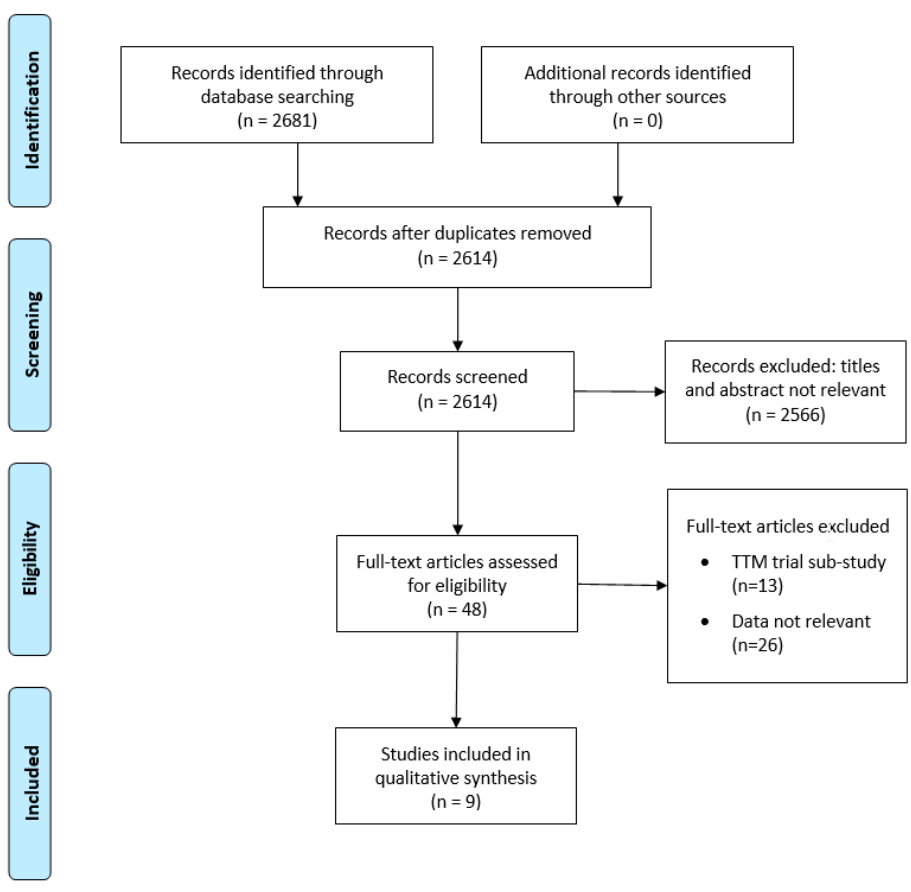
Figure 1. Flow diagram of the search results and selection of eligible studies. TTM = target temperature management. Table 1. Summary of the selected studies comparing target temperature management at 33 and 36 °C. For mortality and neurological outcome assessment, “ICU” and “Hospital” refer to ICU discharge and hospital discharge.